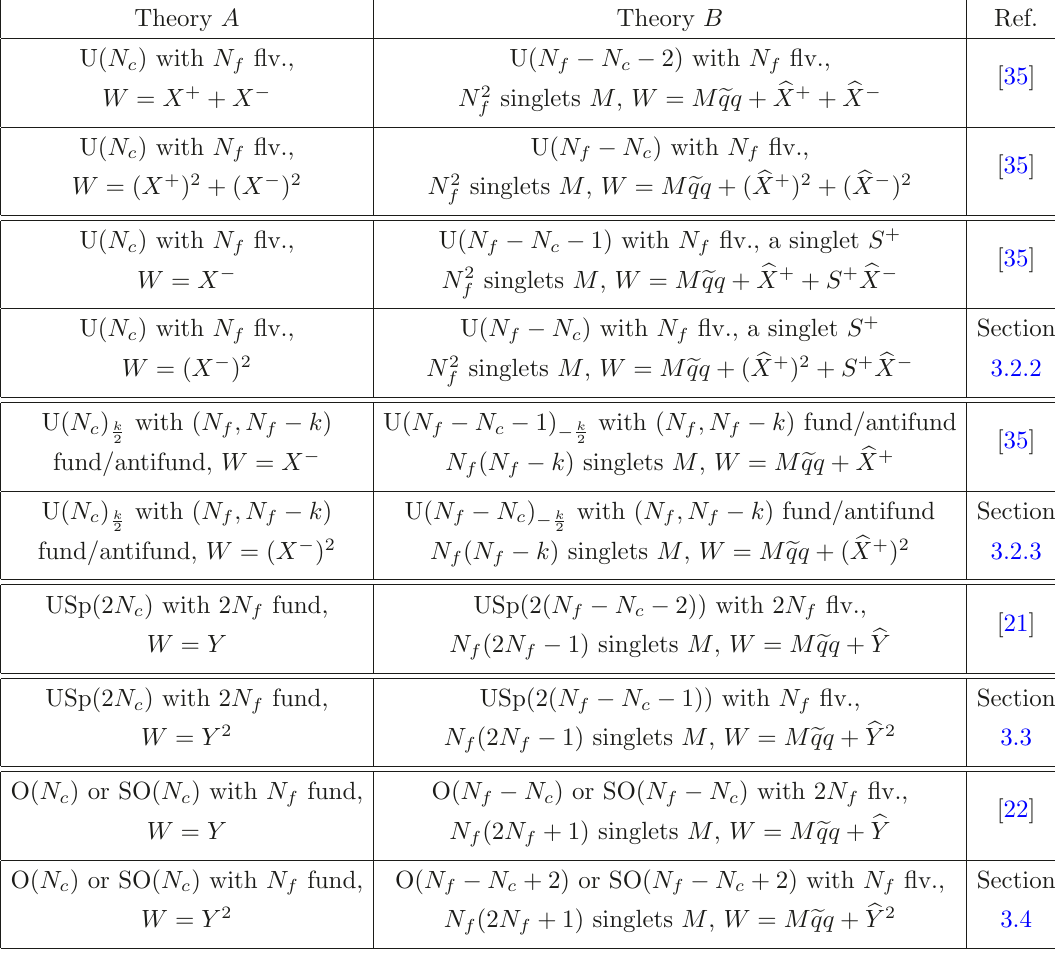
Table 1 . Summary of the